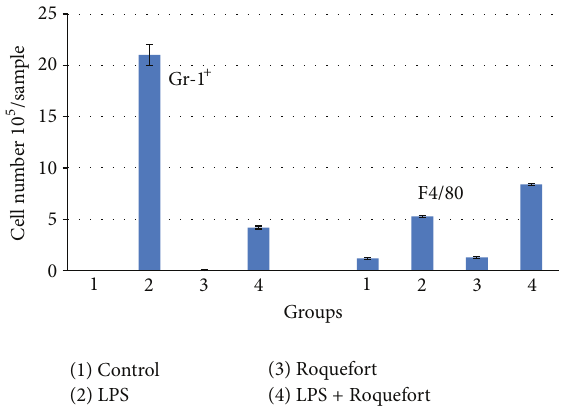
Figure 3: Neutrophil (Gr-1 + ) and macrophage (F4/80) counts in peritoneal washes obtained from LPS-stimulated mice fed with Roquefort cheese. Mice were gavaged twice (once daily) with PBS containing 10.0 mg of the Roquefort protein extract or PBS alone (control). 24 hours later, the animals were injected intraperitoneally with LPS or its solvent (PBS). Peritoneal washes were obtained 48 hours after LPS injection. Neutrophil (Gr-1 + ) and macrophage (F4/80) populations were quantified as described in Section